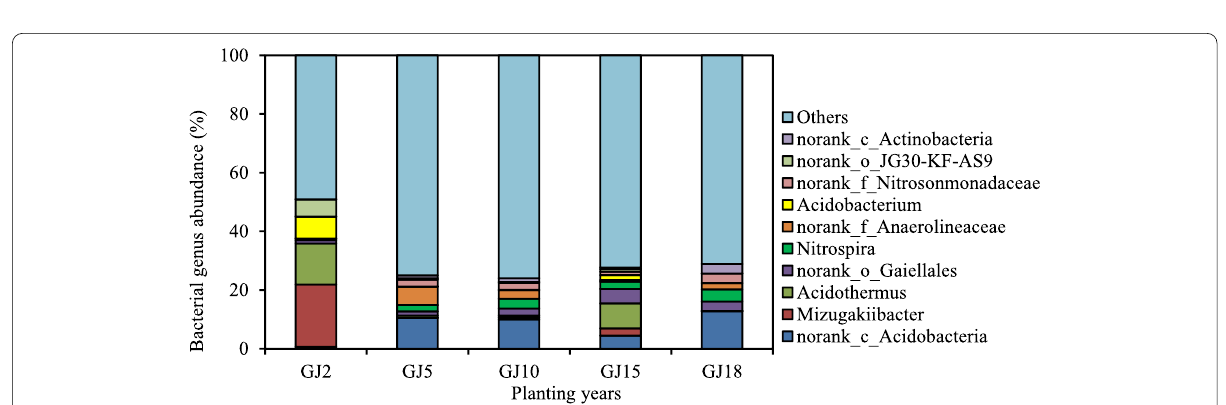
Fig. 4 Soil bacterial genus levels distribution of citrus tree orchards with different